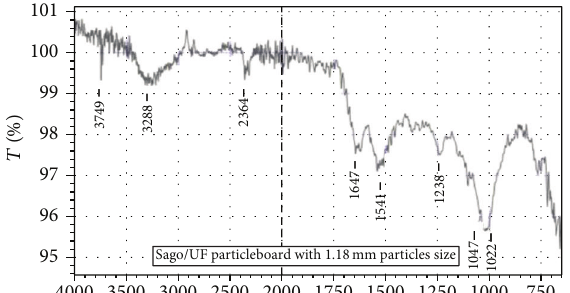
Figure 4: Sample B: Sago/UF Sample with particles size